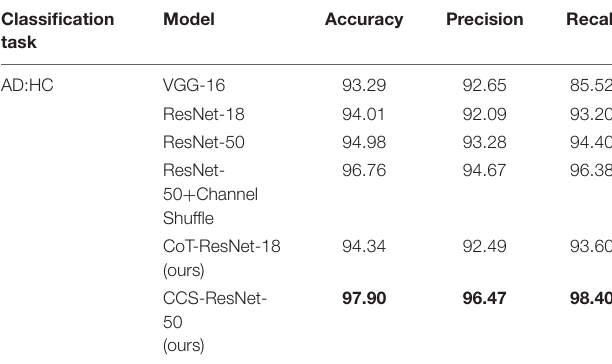
TABLE 5 | Experimental results of AD:HC classification on MRI slices (unit: %).